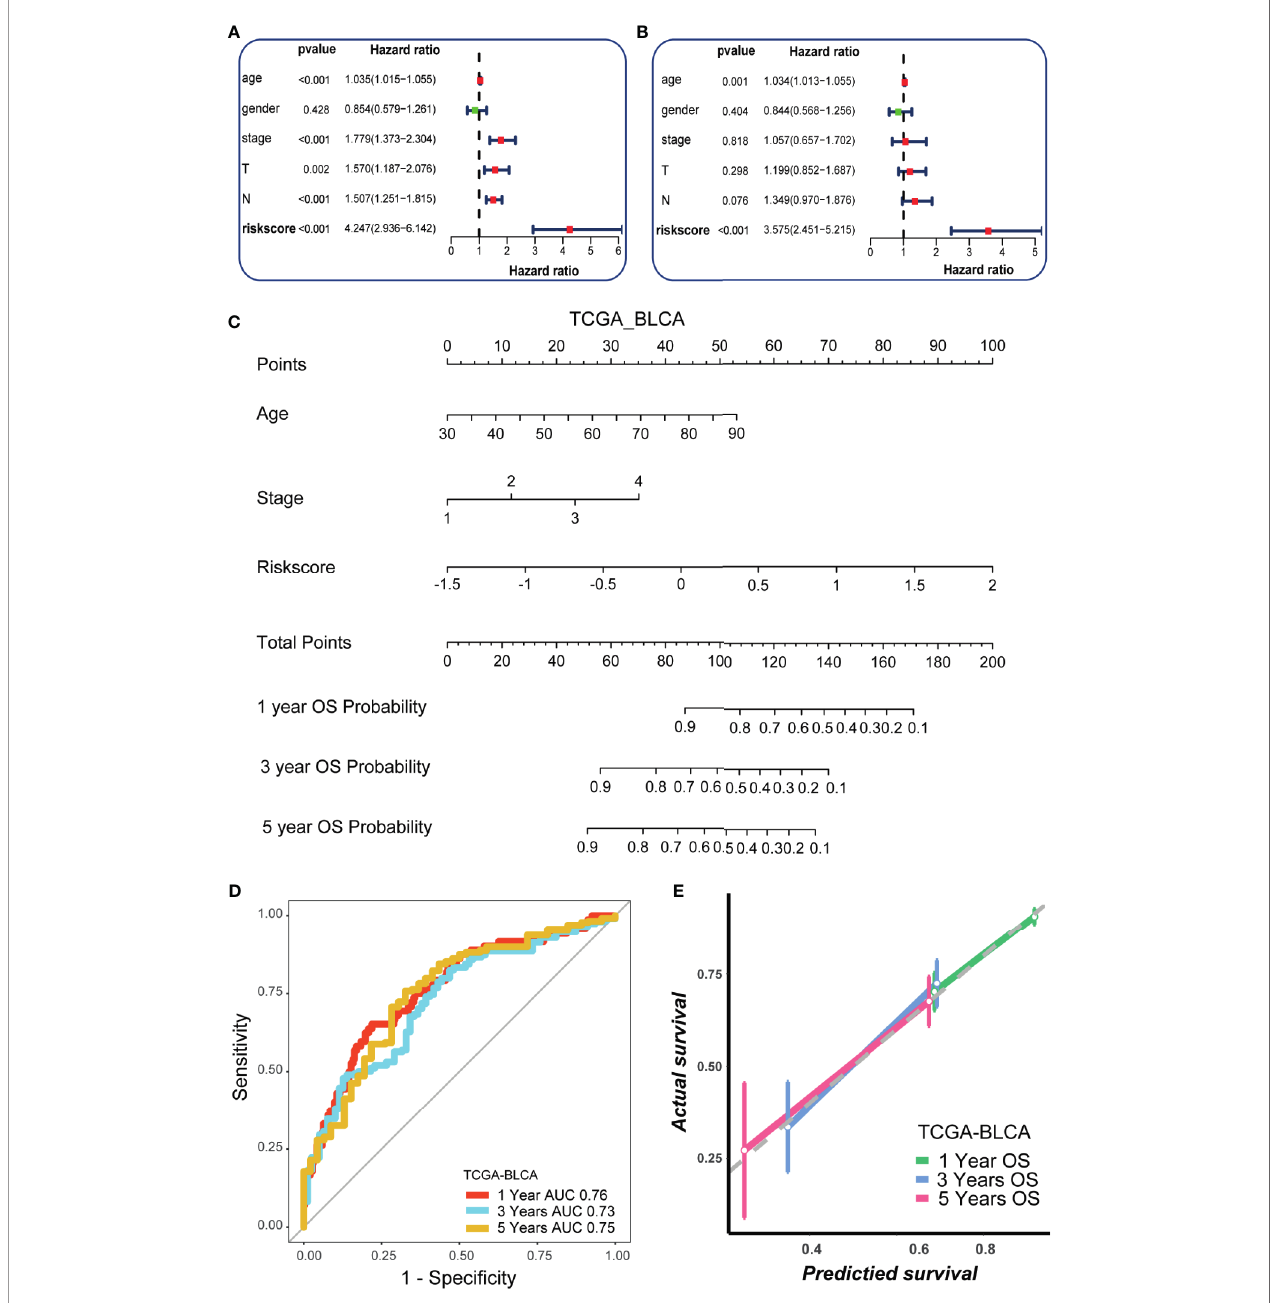
FIGURE 2 | Development of a nomogram by integrating the hypoxia risk score and clinicopathological characters in TCGA-BLCA cohort. (A) Results of univariate Cox analysis. (B) Results of multivariate Cox analysis. (C) The developed nomogram to predict the 1-year, 3-year, and 5-year overall survival. (D) The ROC curves of the nomogram. (E) Calibration curves of the nomogram measured by Hosmer-Lemeshow